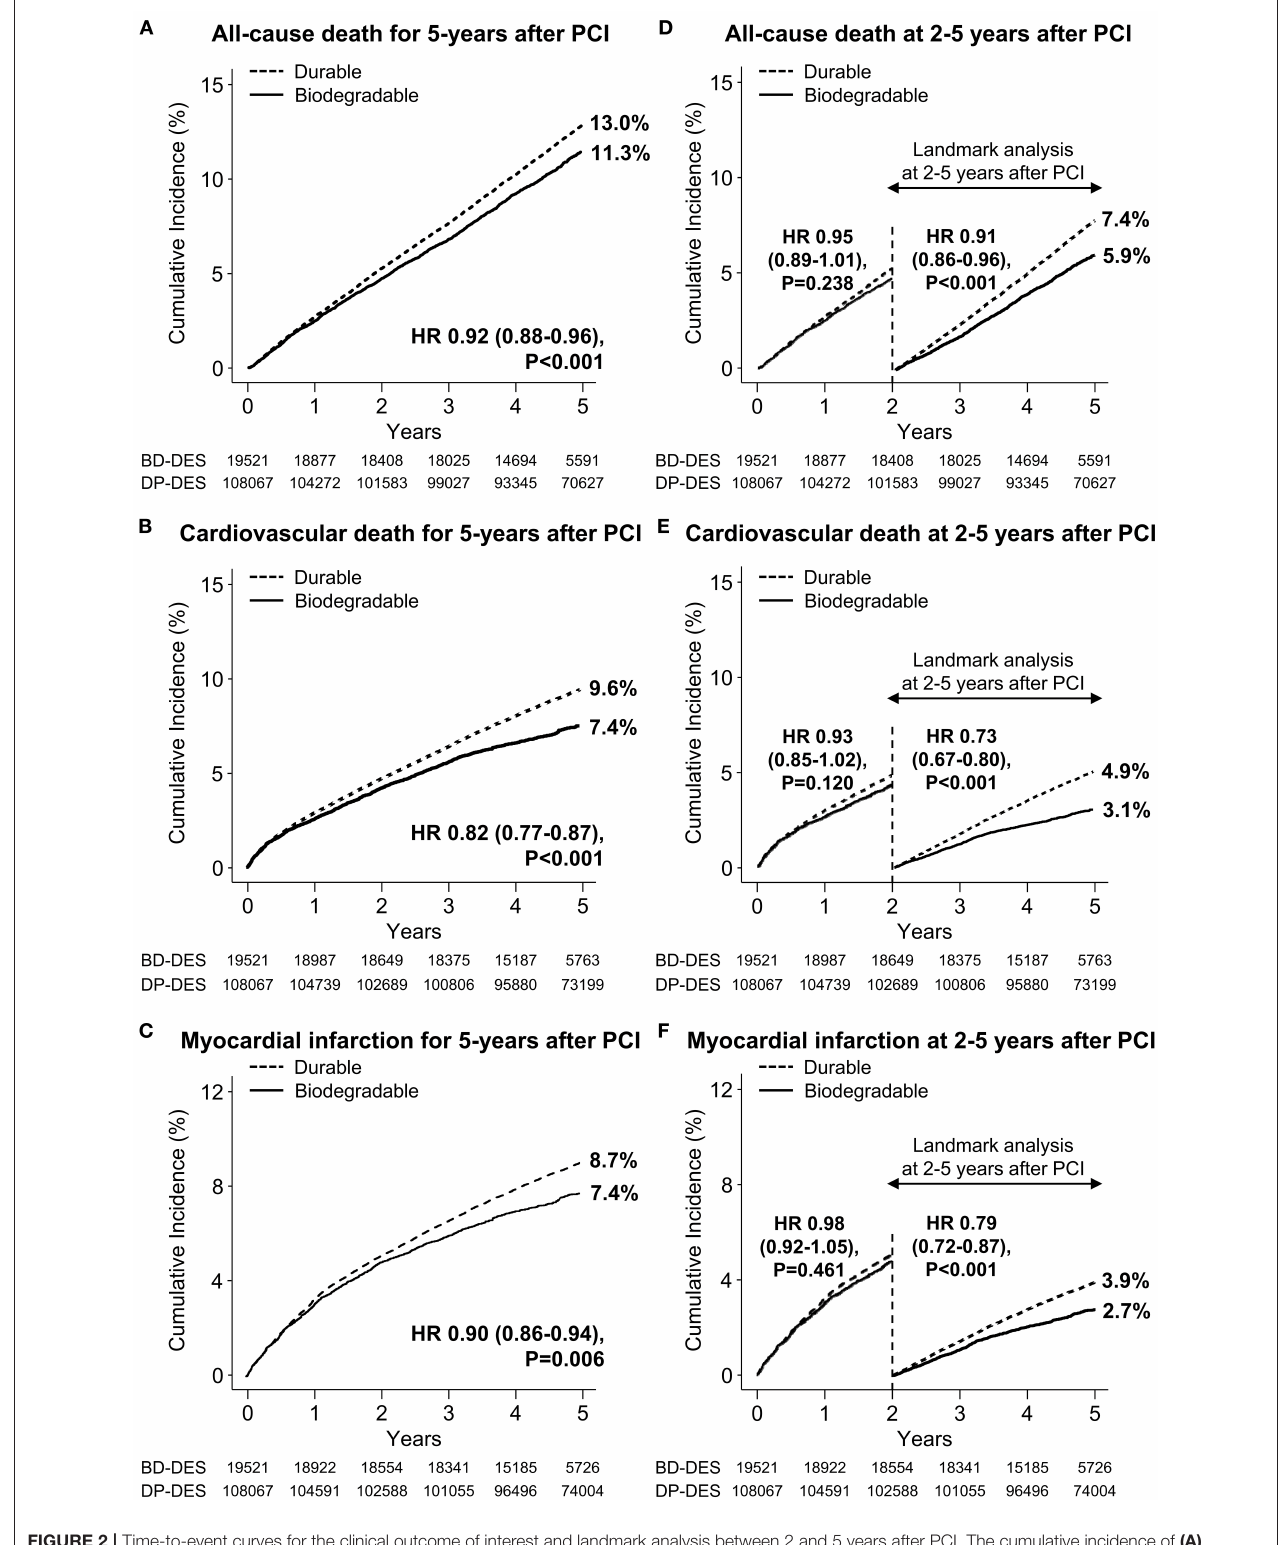
Frontiers in Cardiovascular Medicine |